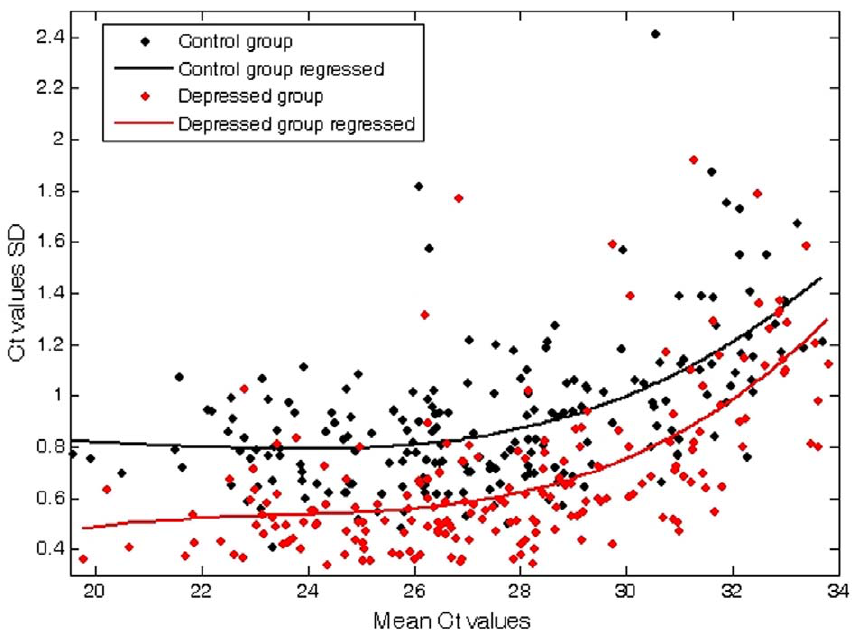
Figure 1. Plot of Mean vs standard deviation (SD) for normal control and depressed suicide groups. miRNA expression in the depressed suicide group is significantly less variable than in the control group.